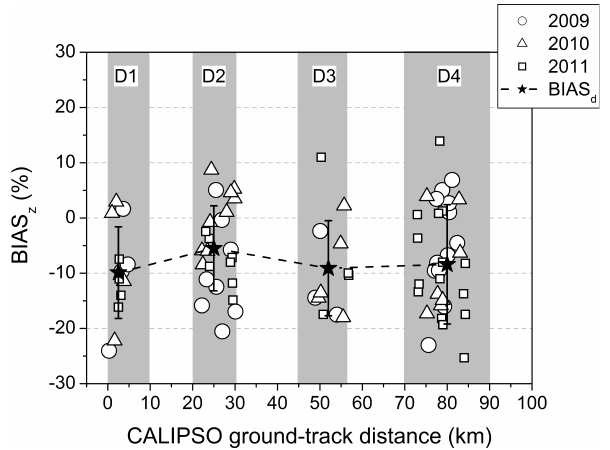
Fig. 7. Height-averaged BIAS, BIAS z , in dependence on the CALIPSO ground-track distance from Belgrano II station for 2009 (circles), 2010 (triangles) and 2011 (squares) wintertime periods. Those averaged values BIAS d (SD is marked by error bars) on each CALIPSO predominant separation (from D1 to D4) are also shown (black